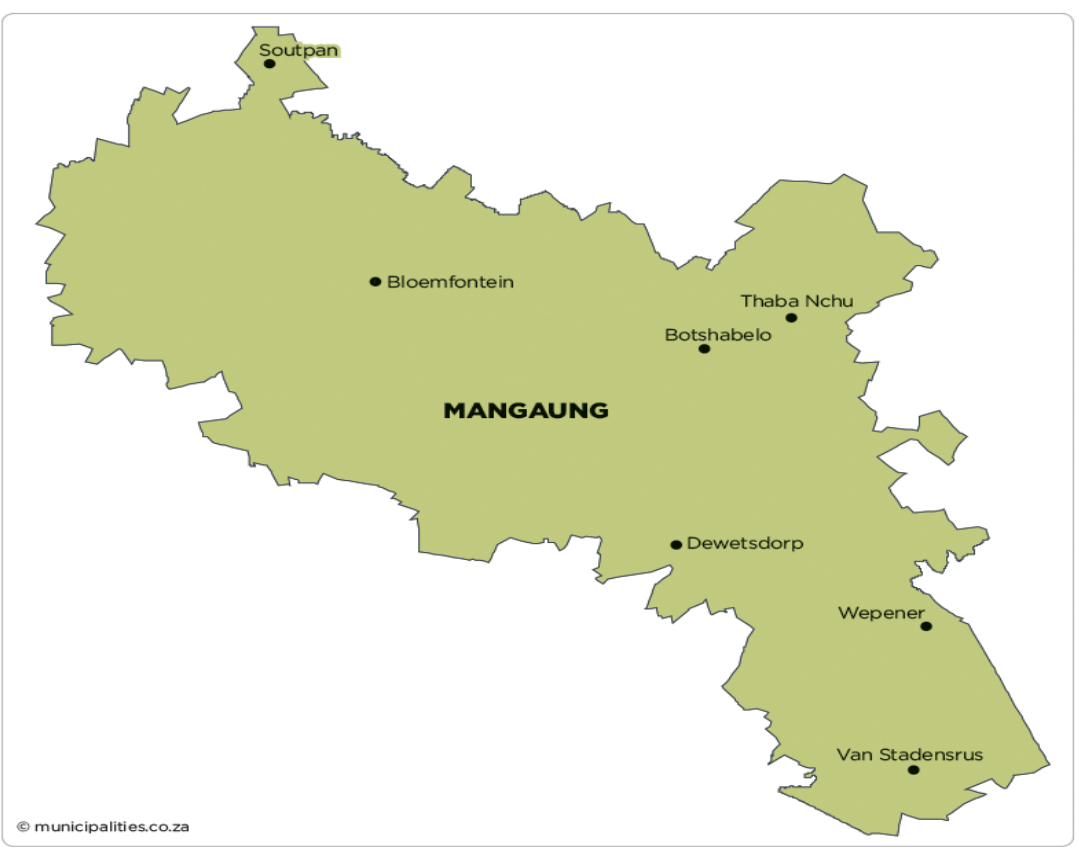
Figure 2. Location of the study area. Source: Mangaung Metropolitan Municipality .